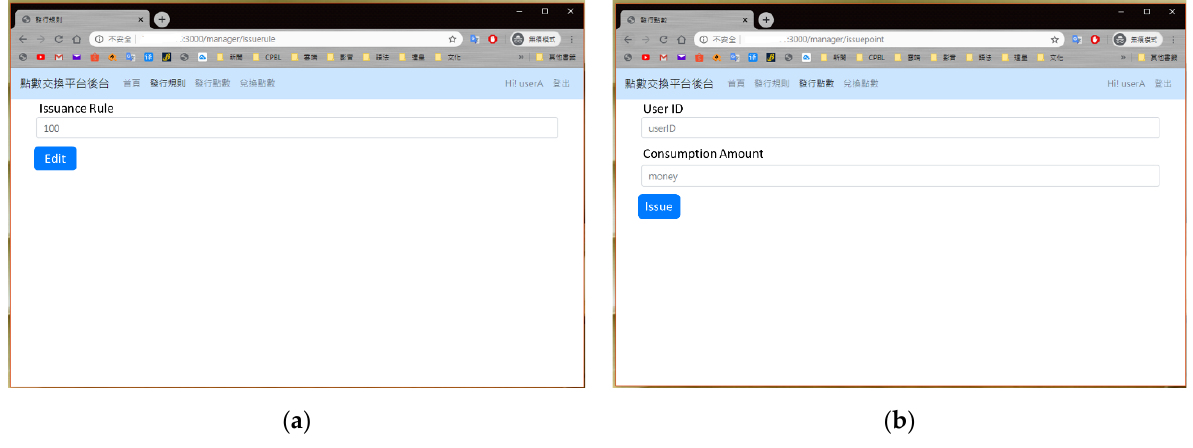
Figure 5. User interface of issuance.